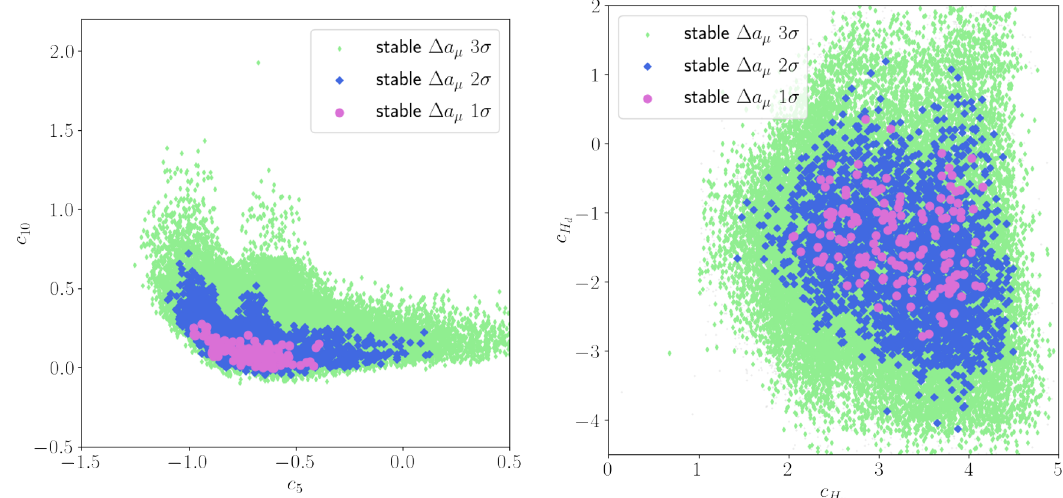
Figure 3 . Parameter points in the space of ( c 5 , c 10 ) (left) and ( c H colored in magenta, blue, and green can explain the muon g − 2 anomaly within 1 σ , 2 σ , and 3 σ ,